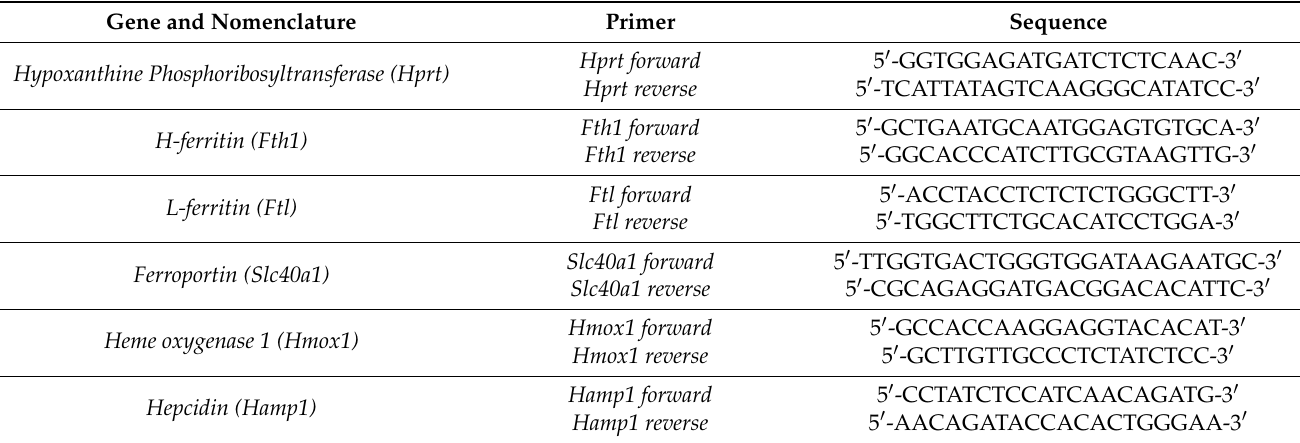
Table 2. Primers